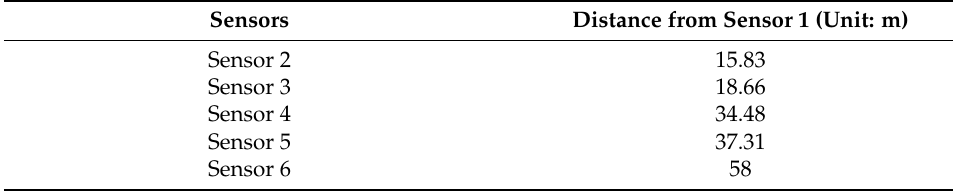
Figure 4. Schematic diagram and photo of the measured experiment. Table 1. Specific positions of the sensors.